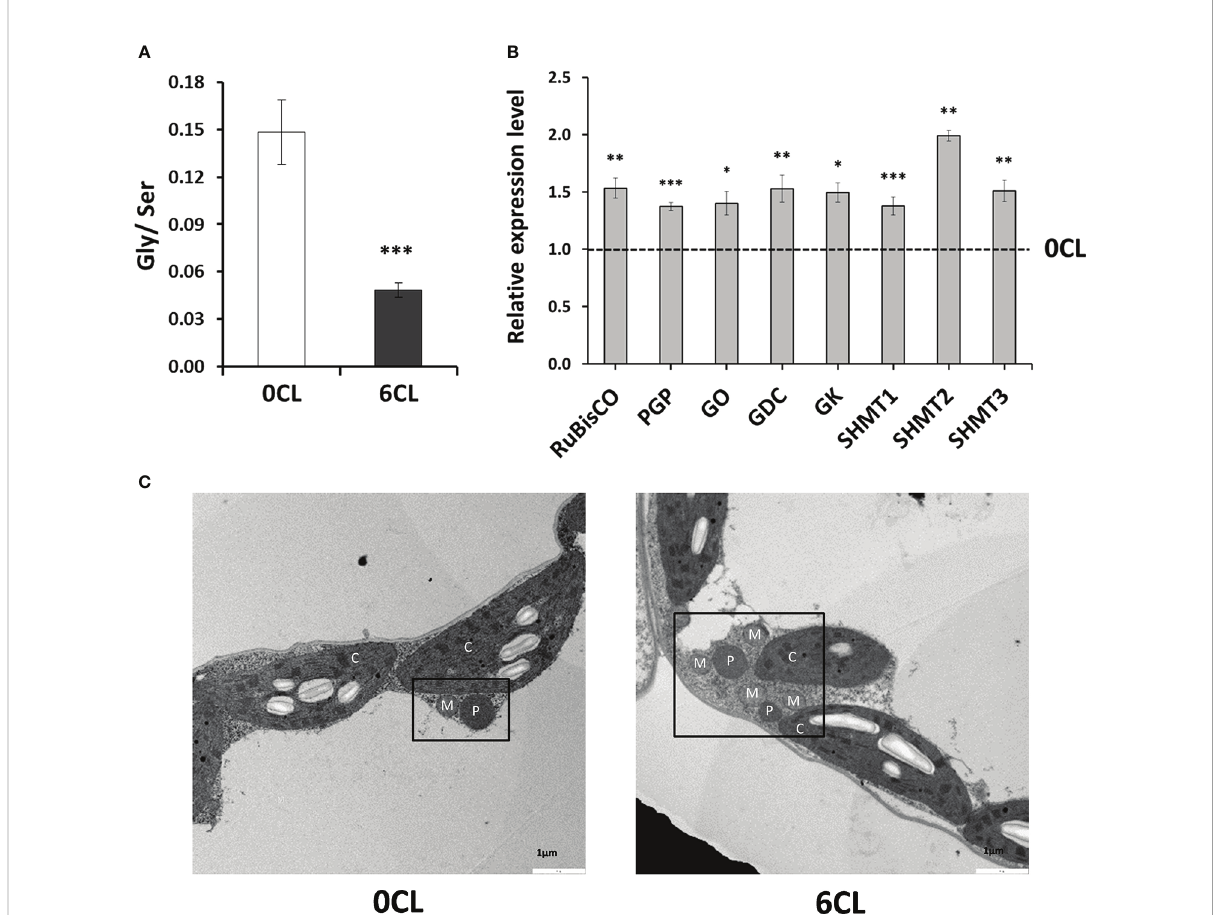
FIGURE 6 Effect of Cl − nutrition on photorespiration. Tobacco plants were treated with 0 and 6 mM of Cl − salts (CL), and supplemented with a mix of sulphate +phosphate salts to maintain a similar cationic balance. (A) Glycine/Serine (Gly/Ser) ratio; (B) Relative expression level of photorespiration-related enzymes: ribulose-1,5-biphosphate carboxylase/oxygenase (RuBisCO), phosphoglycolate phosphatase (PGP), glycolate oxydase (GO), glycine decarboxylase (GDC), serine hydroxymethyl transferase (SHMT), glycine kinase (GK). (C) Transmission electron micrographs showing the ultrastucture of leaf mesophys cells. Organelles that contribute to photorespiration were labelled as M, mitochondrion; P, peroxisome; C, chloroplast;. Mean values ± SE, n =4-6. Statistics was calculated through ANOVA, where mean values with different letters are signi fi cantly different according to Tukey ’ s test at P ≤ 0.05. Levels of signi fi cance: * P ≤ 0.05; ** P ≤ 0.01; *** P ≤ 0.001; and ‘ ns ’ P >